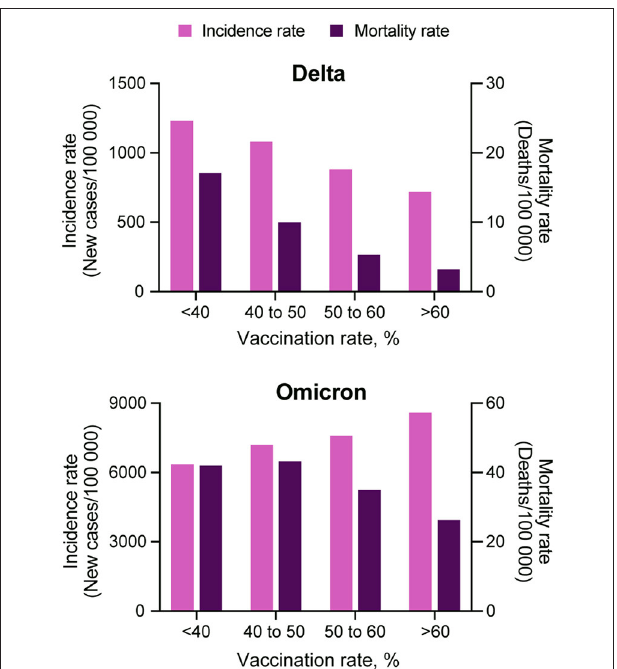
FIGURE 2 | Comparison among COVID-19 incidence and mortality rate and vaccination coverage. COVID-19 incidence (light purple bars) and mortality (dark purple bars) rate estimations for each of the four vaccination rate groups, < 40, 40 to 50, 50 to 60% and more than 60%, during the Delta (July 1, 2021 to August 31, 2021) and Omicron (December 1, 2021 to January 31, 2022) waves in the US.